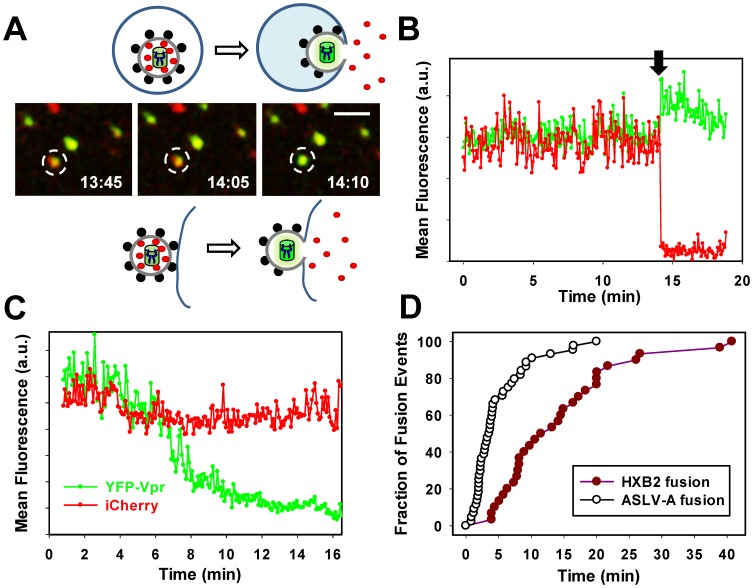
Detection of HIV-1 fusion by content release and intraviral pH-sensing assays.HIV-1 pseudoviruses bearing HXB2 Env and co-labeled with YFP-Vpr and Gag-iCherry were spinoculated onto CV-1/CD4/CXCR4 cells in the cold. Cells were washed and imaged at 37°C. (A) Images of single virus fusion leading to loss of the iCherry signal (red). Time stamps (in min:sec) indicate the time after shifting the cells to 37°C (see also movie S1). Scale bar is 2 µm. Cartoons above and below the image panel illustrate that this labeling approach does not discern between virus-endosomes (top) and virus-plasma membrane (bottom) fusion. (B) Mean fluorescence intensities of YFP and iCherry signals for the particle shown in panel A. Virus-cell fusion results in simultaneous YFP fluorescence dequenching and loss of the iCherry signal (arrow). (C) An example of a particle that fails to fuse. The slow decrease in the YFP fluorescence is caused by acidification of the virus’ interior, which most likely reflects the pH drop in endosomal compartments. (D) The kinetics of HIV-1 fusion with cells measured as the distribution of waiting times from raising the temperature to loss of iCherry (dark red circles). For comparison, the kinetic of ASLV-A Env-mediated fusion of HIV-1-based particles with CV1 cells expressing TVA950 is also shown (open circles).